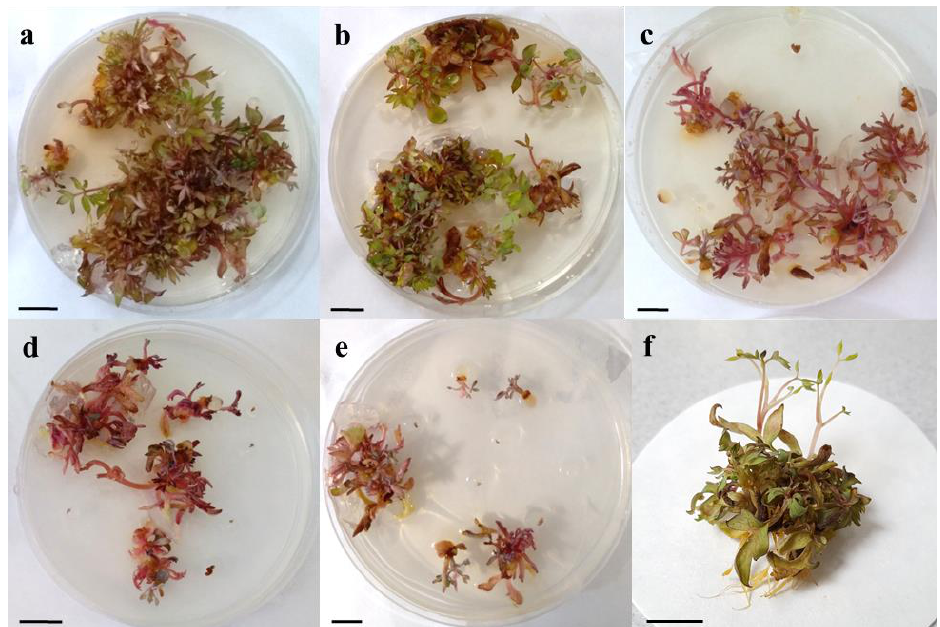
Figure 6. Development of L. spectabilis ‘Gold Heart’ shoots after storage in liquid nitrogen and earlier preculture on the MS medium with various plant extracts: ( a ) Control; ( b ) Coconut; ( c ) Oat; ( d ) Rice; ( e ) Sesame; ( f ) Complete microshoot with roots recovered from the control treatment after 10 weeks of culture; bar = 1 cm.